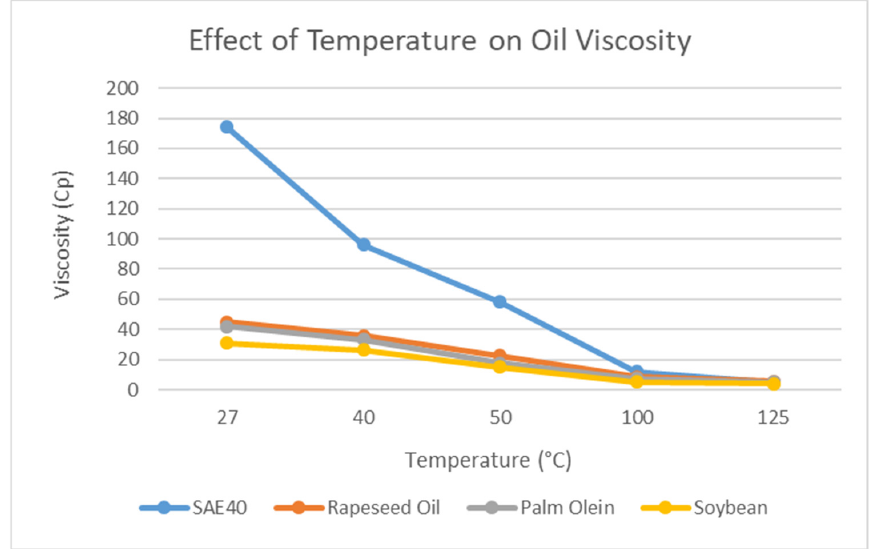
Figure 5. Effect of temperature on oil viscosity.